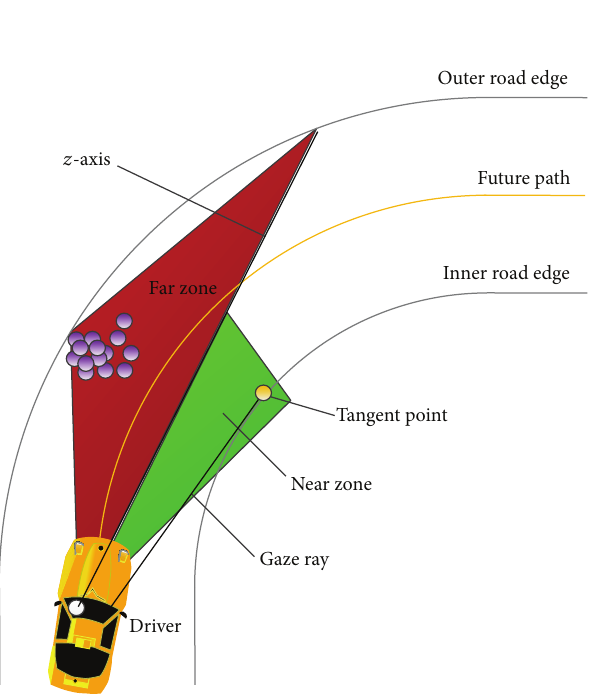
Figure 12: AOIs in right-turning